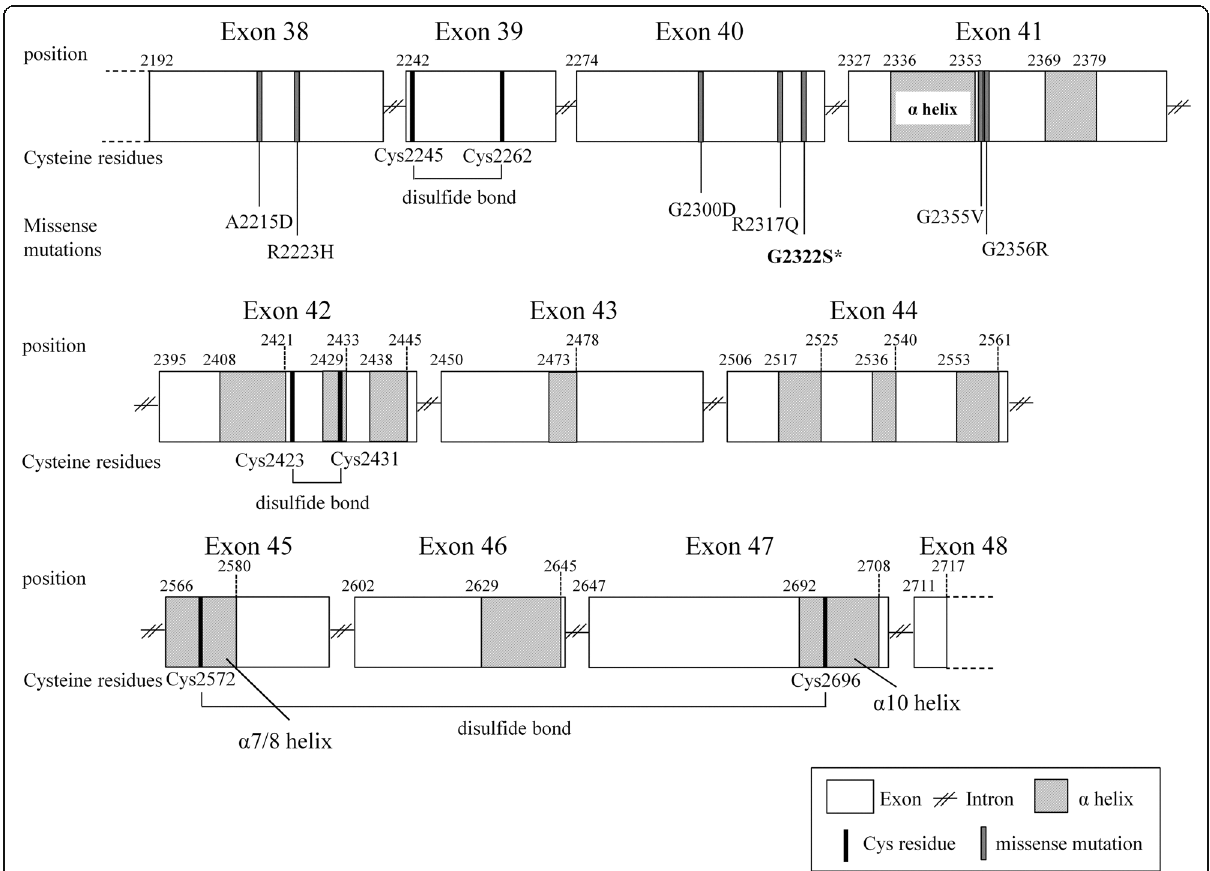
Fig. 6 Schematic representation of ChEL domain in the TG gene. Amino acid numbering is indicated above TG structure. α helix motifs are indicated in gray boxes with diagonal lines. Cystein residues are indicated in black lines. Pathogenic missense mutations are indicated in gray lines. *Mutation in the present case